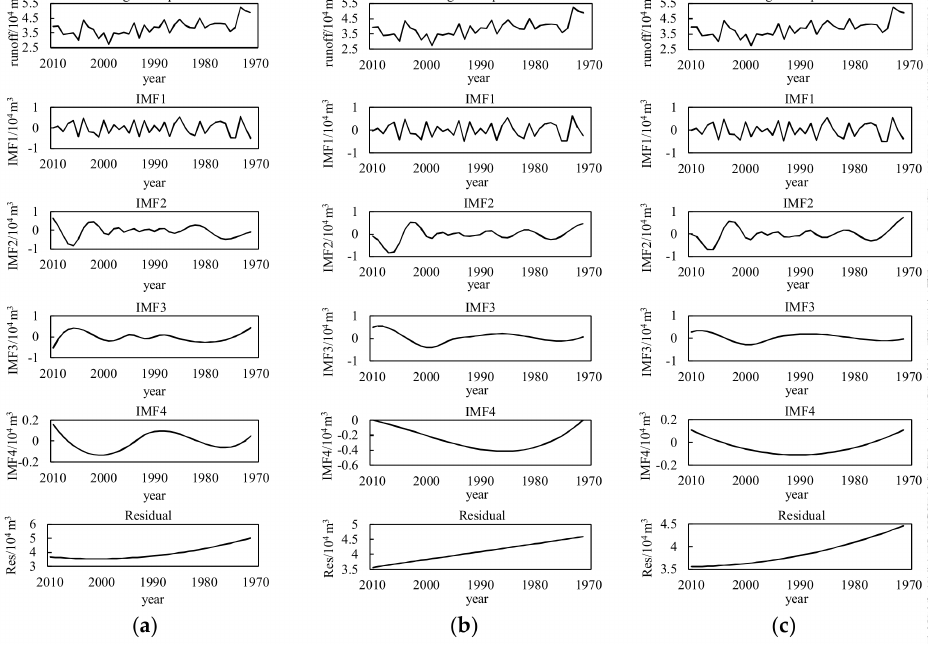
Figure 1. The decomposition results of runoff series based on ( a ) standard deviation (SD) criteria; ( b ) G. Rilling (GR) criteria; and ( c ) the method of tracking energy differences (MTED) at the Zhaoshiyao station.